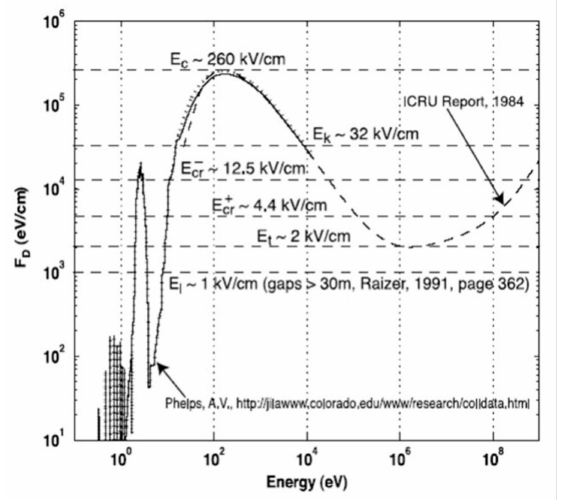
Figure 1. Drag force on electrons in air at density defined by 273 K and 1 bar as a function of electron energy. Adapted from